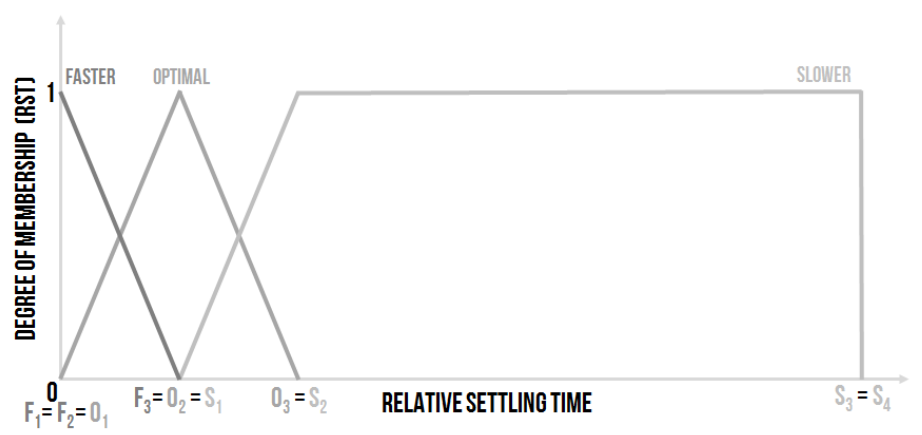
Figure 4. The shape of the membership functions of the linguistic values for the input linguistic variable Relative Settling Time (RST)